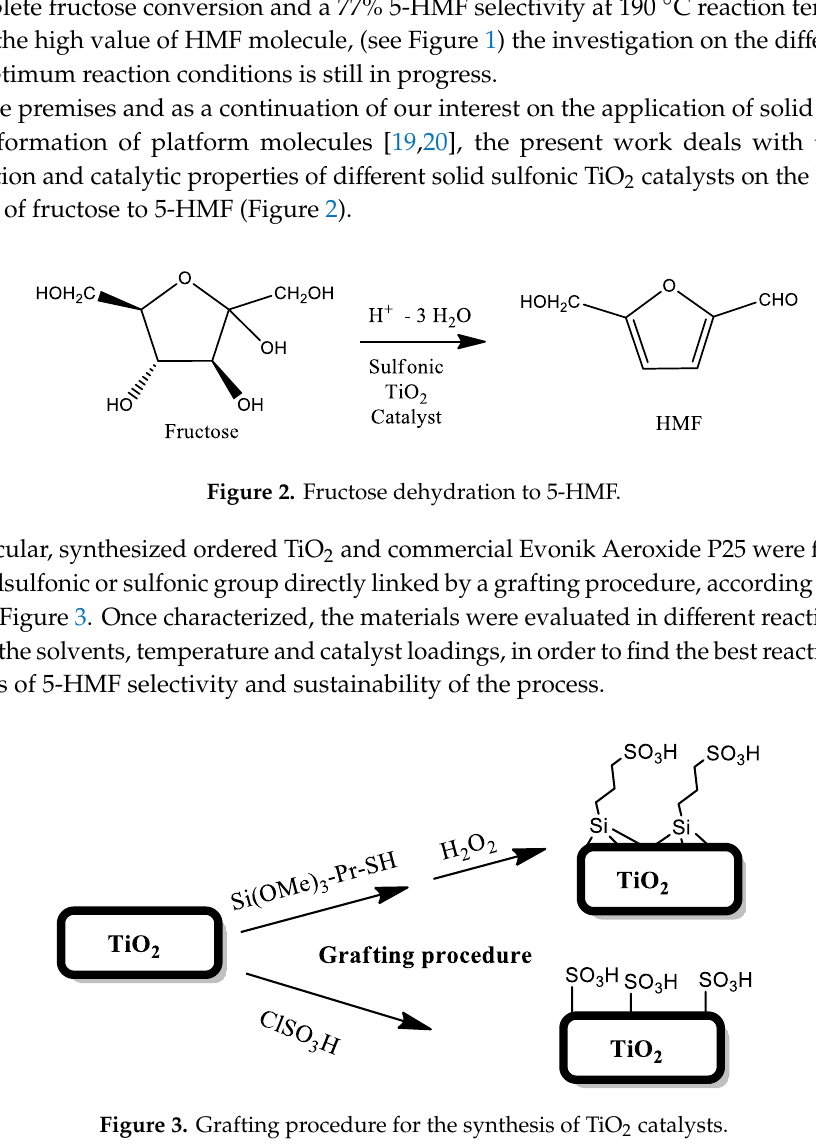
Figure 3. Grafting procedure for the synthesis of TiO 2 catalysts.